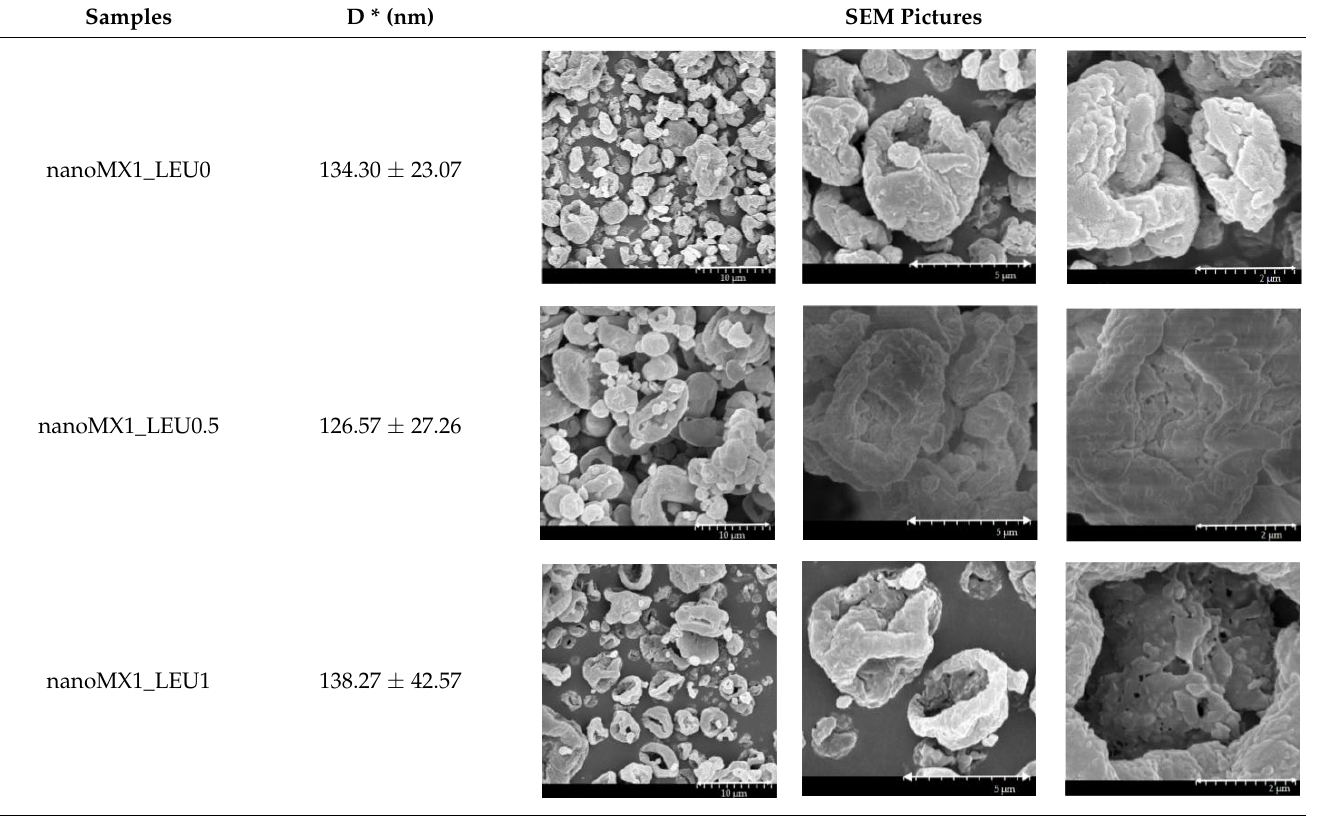
Table 5. Diameter of the API in the products determined by Image-J analyses and the scanning electron microscopy (SEM) images of the spray-dried samples.